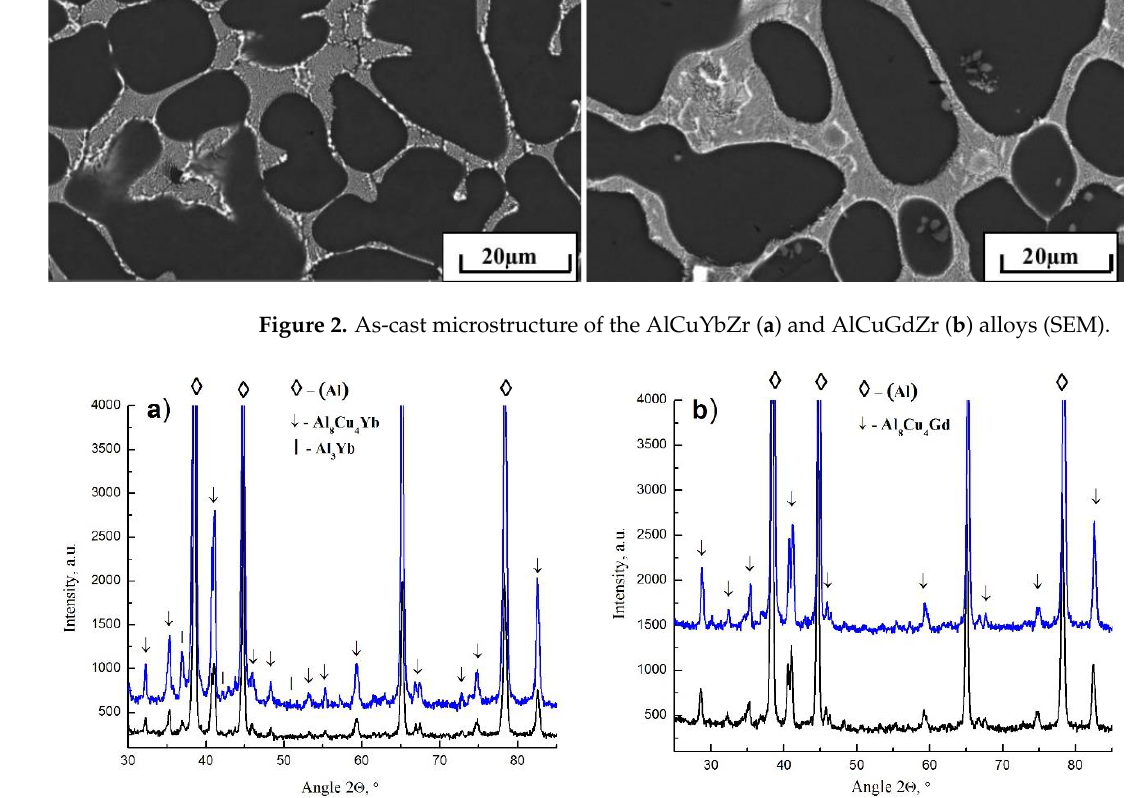
Figure 3. As-cast XRD-patterns of the AlCuYbZr ( a ) and AlCuGdZr ( b ) alloys (blue lines) in com- parison with the AlCuYb ( a ) and AlCuGd ( b ) alloys (black lines) [14]. The solidus temperatures of the AlCuYbZr (Figure 4a) and AlCuGdZr (Figure 4b) alloys were 603 and 613 °С, respectively , as examined by DSC. Based on the DSC results, the homogenization temperatures for AlCuYbZr and AlCuGdZr alloys were 590 and 600 °С, respectively.